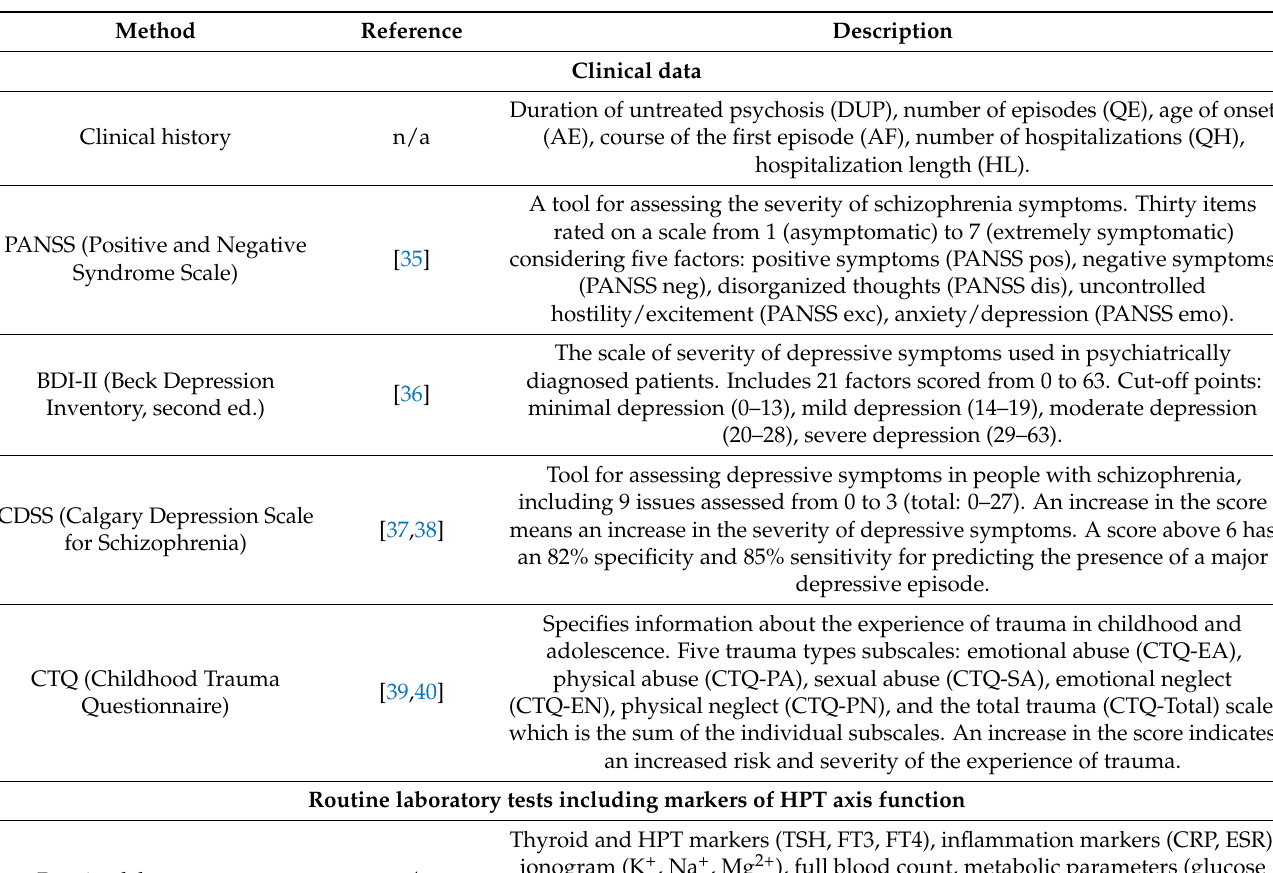
Table 1. Research methods used in the